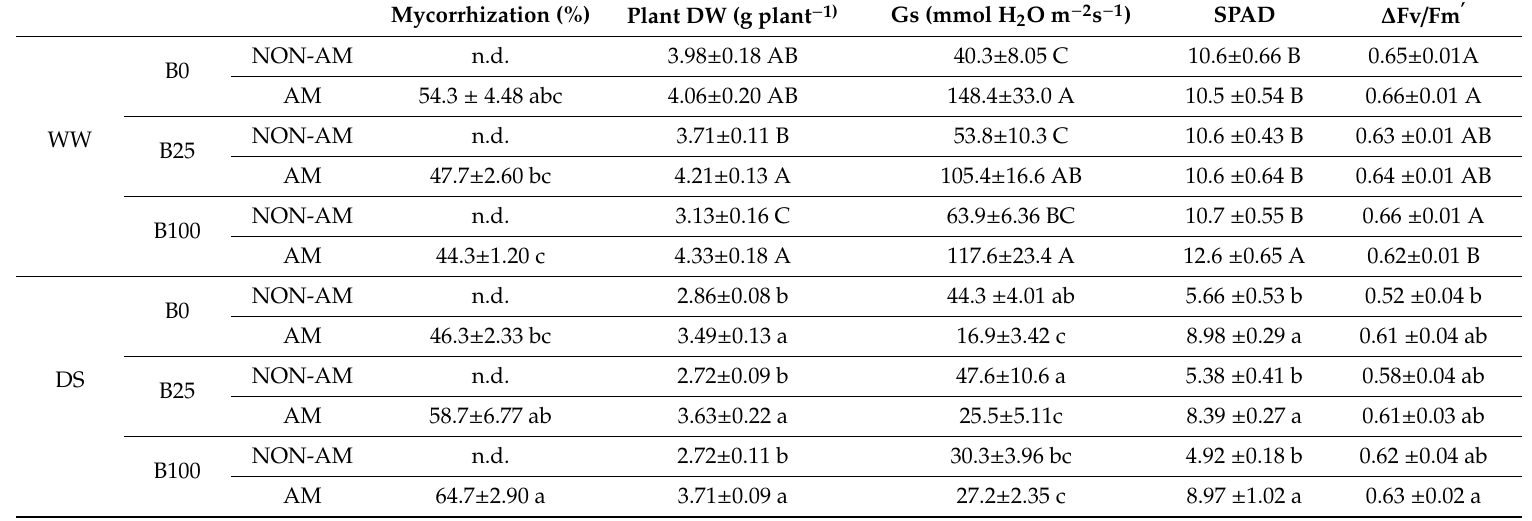
Table 1. Percentage of myocorrhizal root length, plant dry weight (DW), stomatal conductance (gs), chlorophyll SPAD values and photosystem || e ffi ciency in the light –adapted state ( ∆ Fv / Fm ’ ) of maize palnts inoculated or not with the AM fungus Rhizophagus irregularis, submitted to two water regimes (well-watered –WW- or drought stress DS) and supplied with three B levels (B0- 0 µ M, B25- 25 µ M and B 100- 100 µ M). Data represents the menas of three values ± Se for gs, SPAD and ∆ Fv / Fm ’ . Di ff erent letter indicates significant di ff erences between treatments (p < 0.05) based on Duncan’s